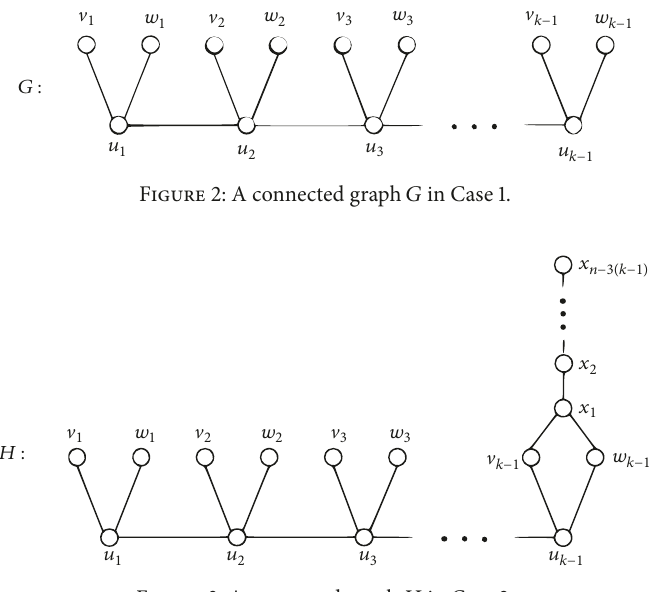
Figure 3: A connected graph 𝐻 in Case